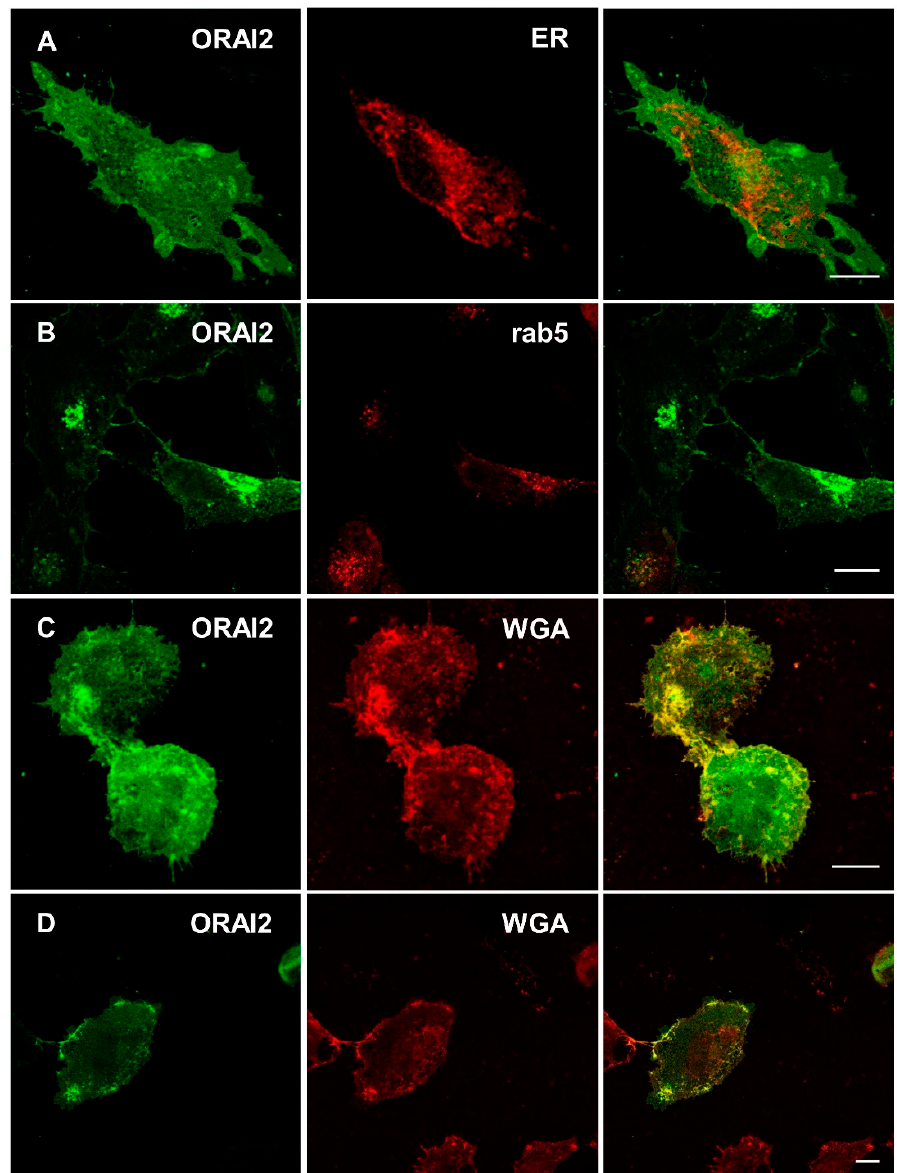
Figure 3. Localization of ORAI2-myc-mVenus in H4 cells. Confocal images of intact H4 cells 24 hours upon transfection with the cDNA coding for ORAI2-myc-mVenus (green, left) together with ER- ( A ) or rab5-mCherry ( B ) (red, middle) and their overlay (right). The cells expressing ORAI2-myc-mVenus were also stained with Wheat Germ Agglutinin (WGA) either before ( C ) or after cell permeabilization ( D ); scale bars 10 μ m.